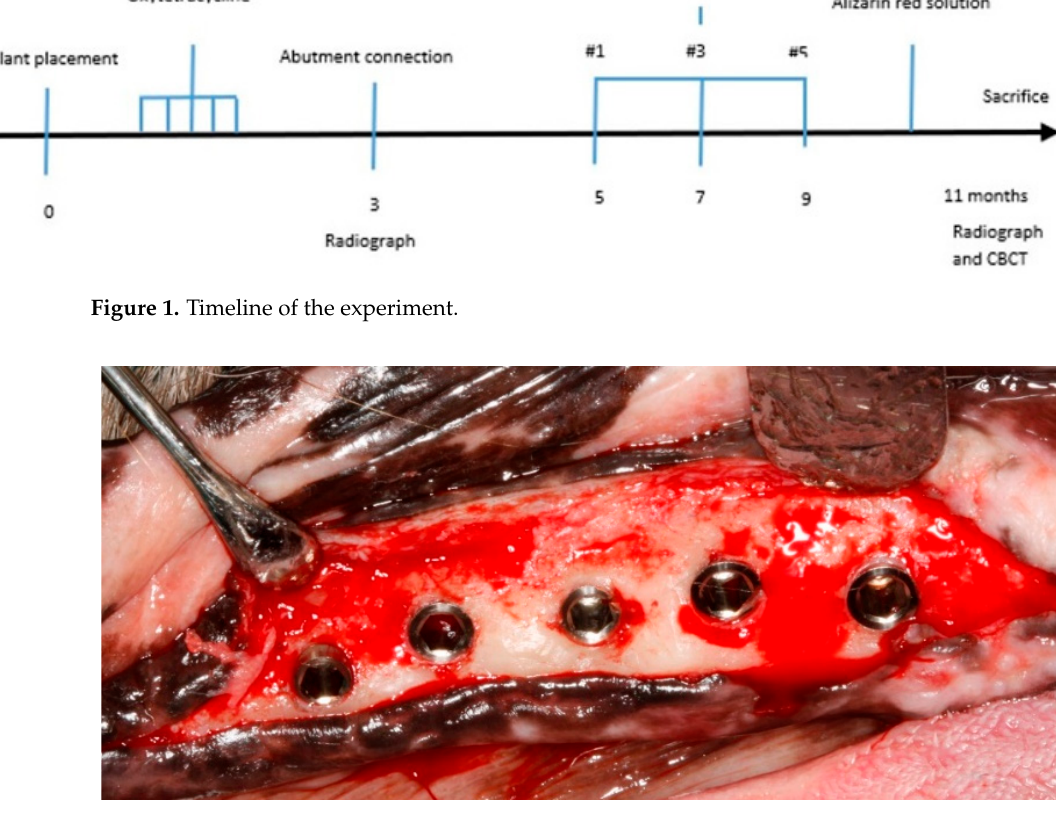
Figure 2. Intra-surgical image after the insertion of the implants. Note the integrity of the buccal bone, as a consequence of the rigorous prosthetic-driven implant placement.